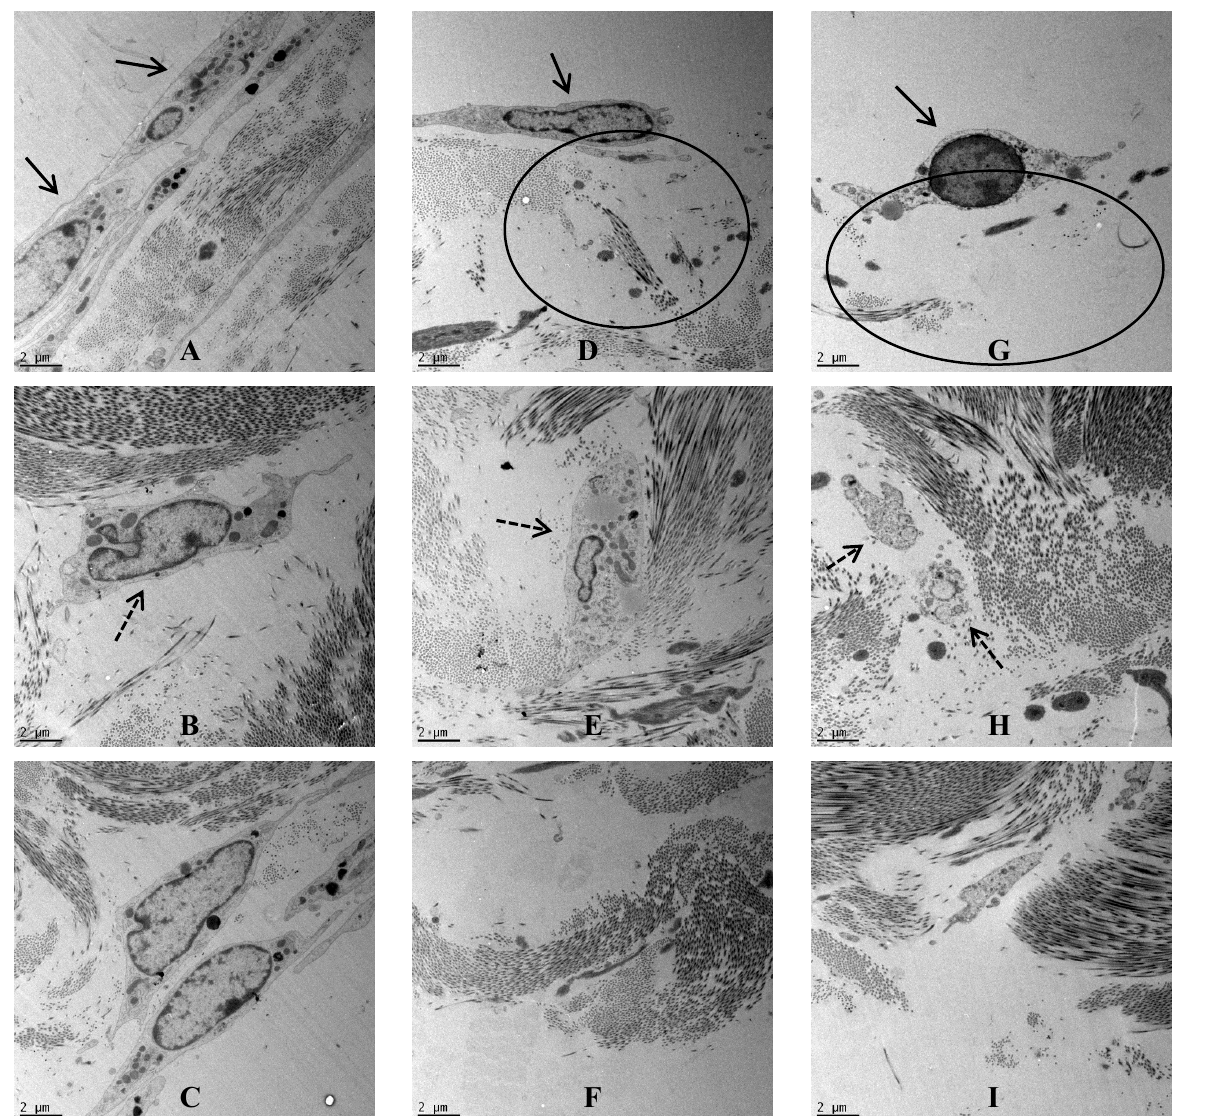
Figure 3. TEM images across the dura mater tissue that was exposed to CoCr nanoparticles for a period of seven days. ( A – C ) Images of the control dura mater from the epithelial region ( A ), inner collagen region ( B ) and the basal side of the dura mater close to arachnoid mater ( C ); ( D – F ) Images of the dura mater exposed to an estimated dose of 5 µm 3 of CoCr particles per epithelial cell, from the epithelial region ( D ), inner collagen region ( E ), and the basal side of the dura mater close to arachnoid mater ( F ); ( G – I ) Images of the dura mater exposed to an estimated dose of 50 µm 3 of CoCr particles per epithelial cell, from the epithelial region ( G ), inner collagen region ( H ), and the basal side of the dura mater close to arachnoid mater ( I ). Single continuous black arrows indicate the dural epithelial cells. Single dotted black arrow indicated the dural fibroblast cells. Black circles indicated disruption of the collagen